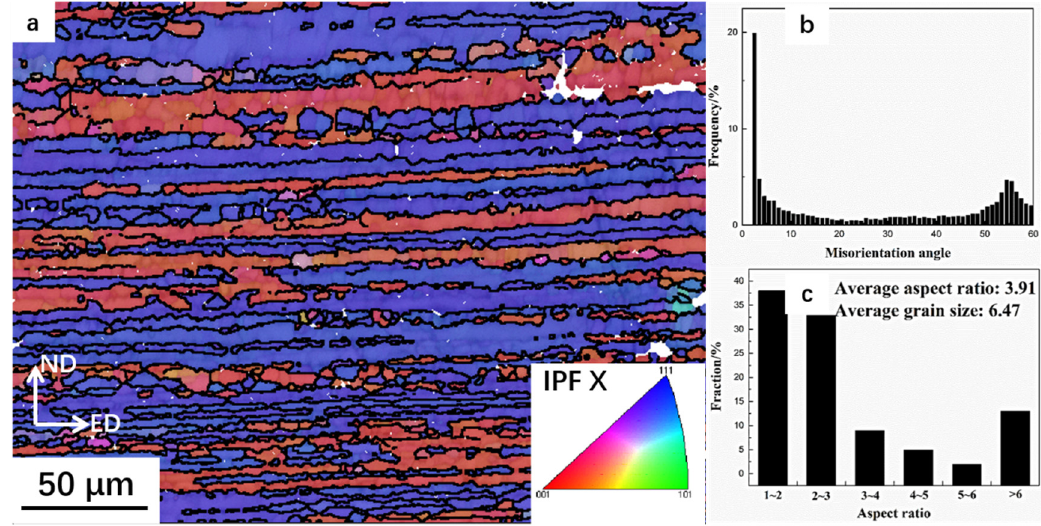
Figure 4. ( a ) Electron backscattered diffraction (EBSD) maps of the specimens after AOEP colored by inverse pole figure (IPF) with axis parallel to the extrusion direction; ( b ) the misorientation angle distribution and ( c ) aspect ratio and average grain size.